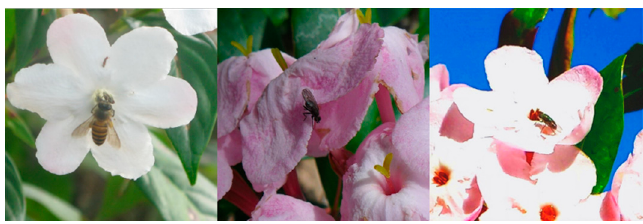
Figure 2. Flowers of L. yunnanensis visited by different insects.